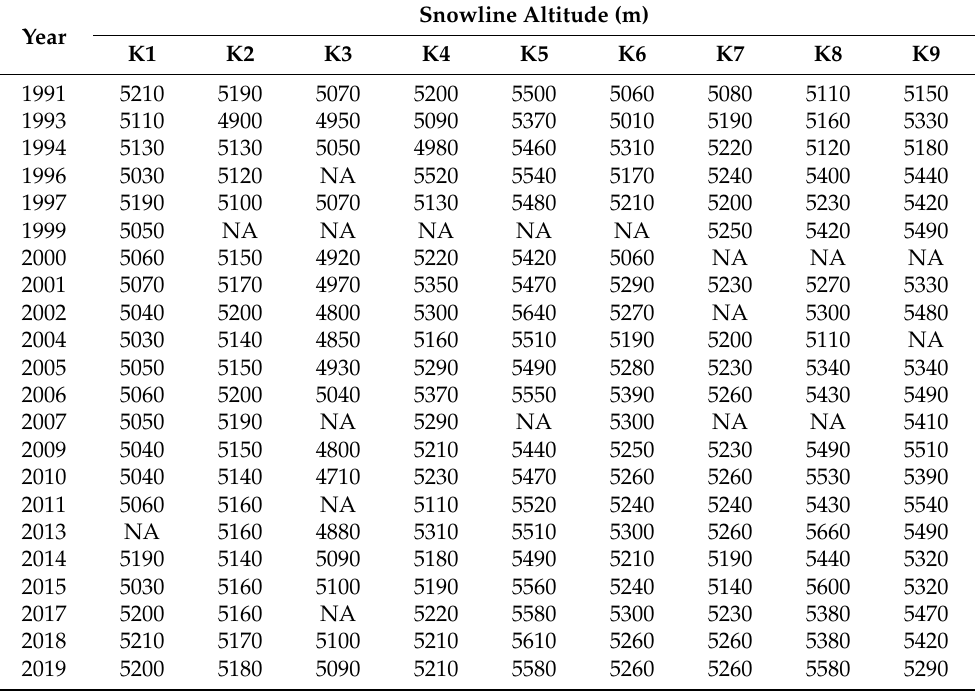
Table 4. SLA of the nine analyzed glaciers across the Karakoram Mountains during the 1989–2019